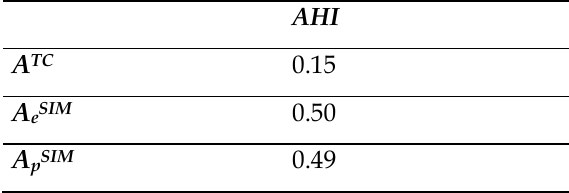
Table 5. Coefficients of correlation between AHI and the different accessibility indicators .